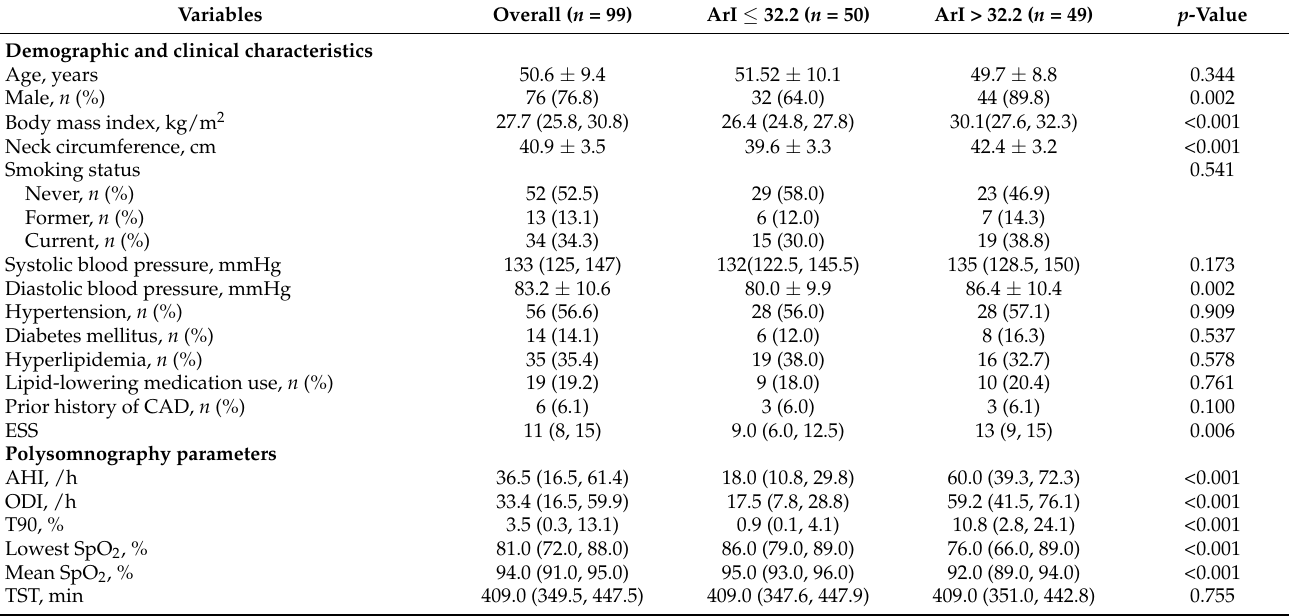
Figure 1. Flow diagram of the study. CTA = computed tomography angiography; OSA = obstructive sleep apnea; PSG = polysomnography. Table 1. Baseline characteristics of the study population.